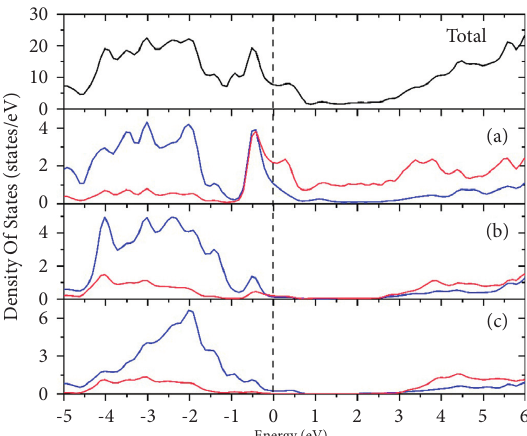
Figure 7: DOS and PDOS for the GaN (001) surface: (a), (b), and (c) exhibit the PDOS of the 1 st , 2 nd , and 3 rd GaN bilayers, respectively. The red and blue lines correspond to Ga-p and N-p, respectively.